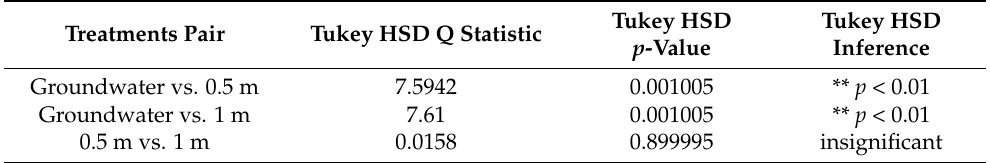
Table 3. Tukey’s honest significance test results for